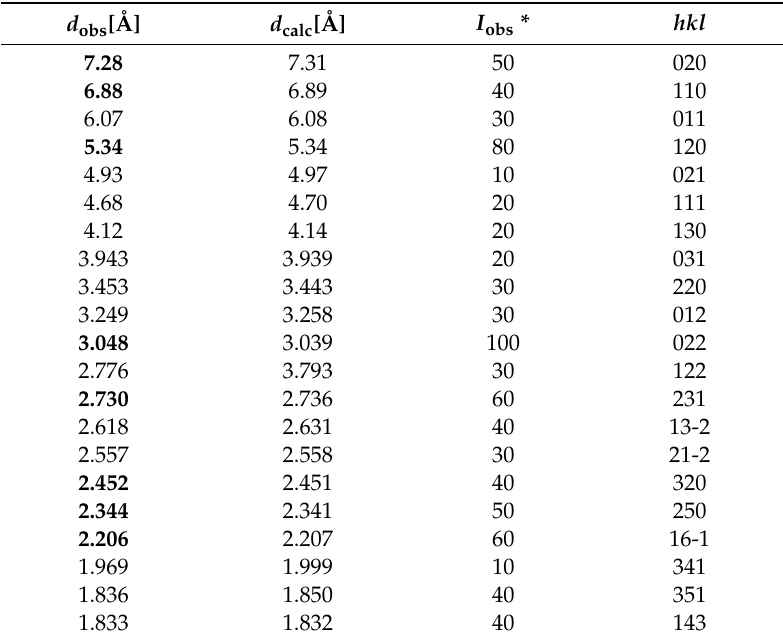
Table 2. X-ray powder di ff raction data for rüdlingerite from Fianel. The strongest di ff raction lines are given in